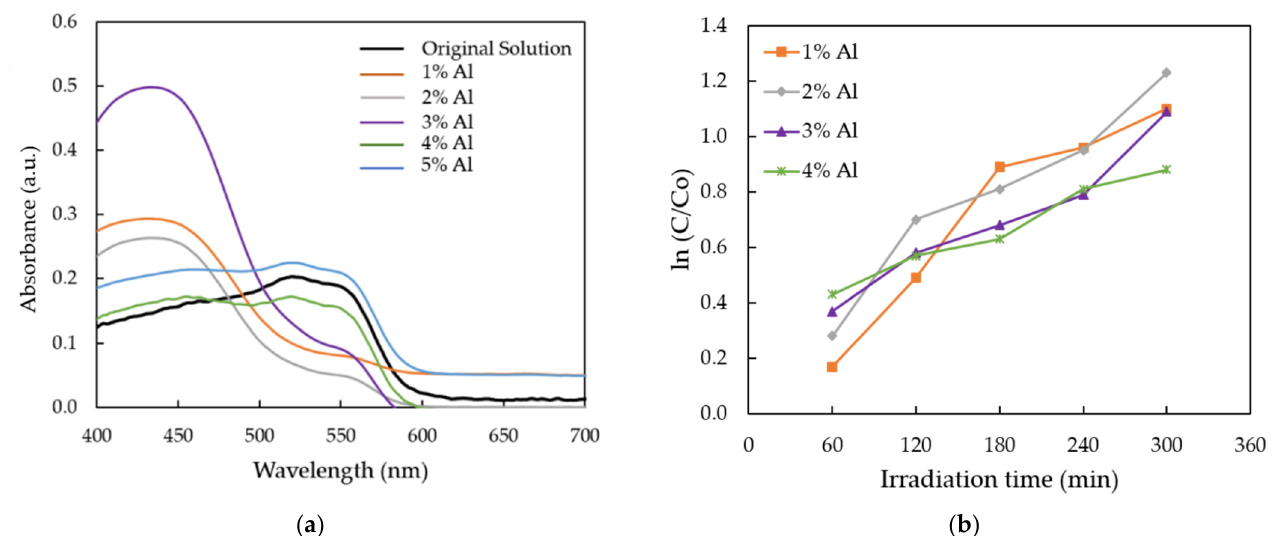
Figure 7. ( a ) The absorption spectra of MR solution for AZO films deposited with different Al doping ratios; and ( b ) plot of ln (C/Co) versus the reaction time.